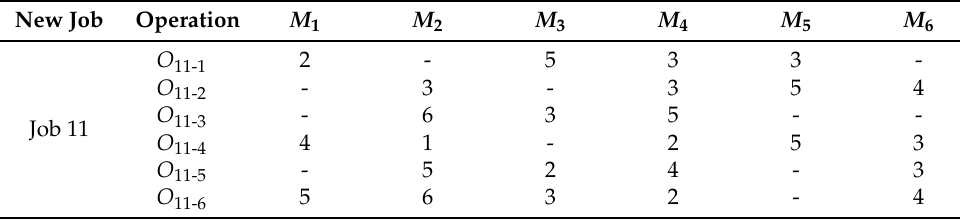
Table 12. Information about the newly inserted